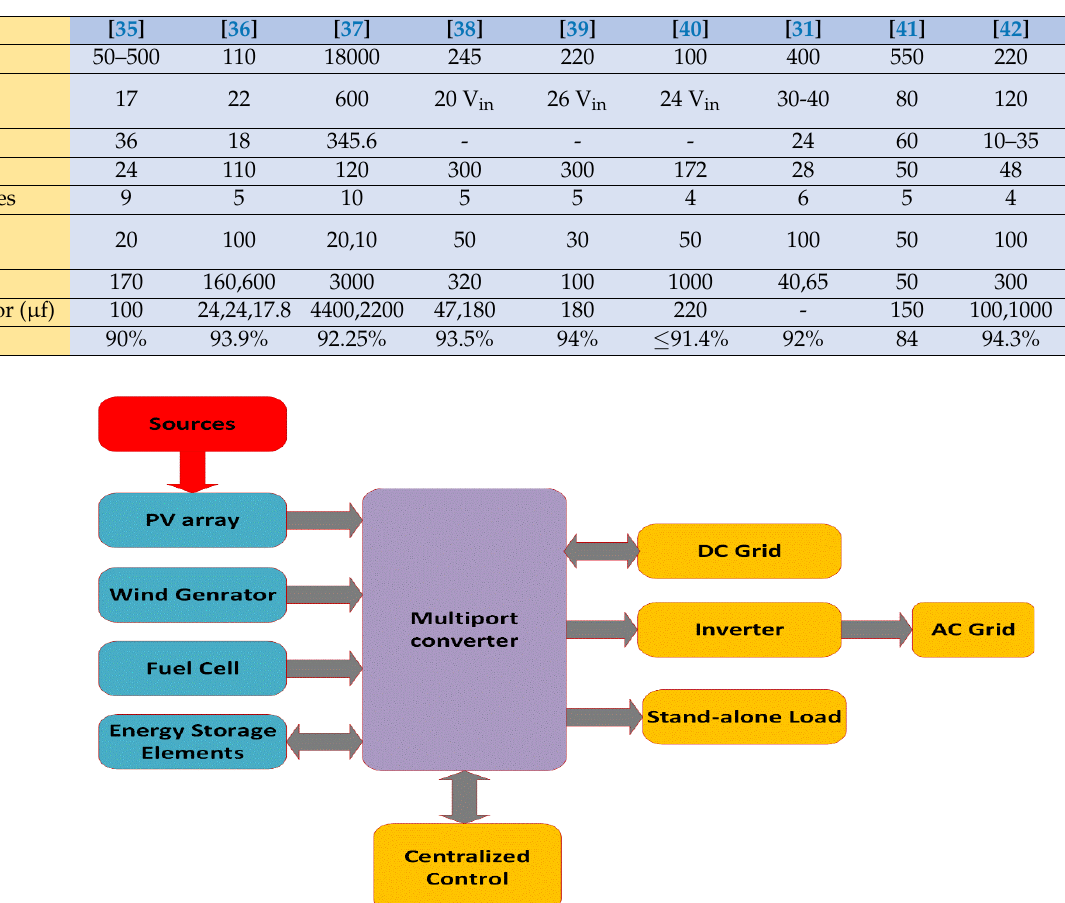
Figure 11. Non-isolated compact multiport DC-DC converter for renewable applications.